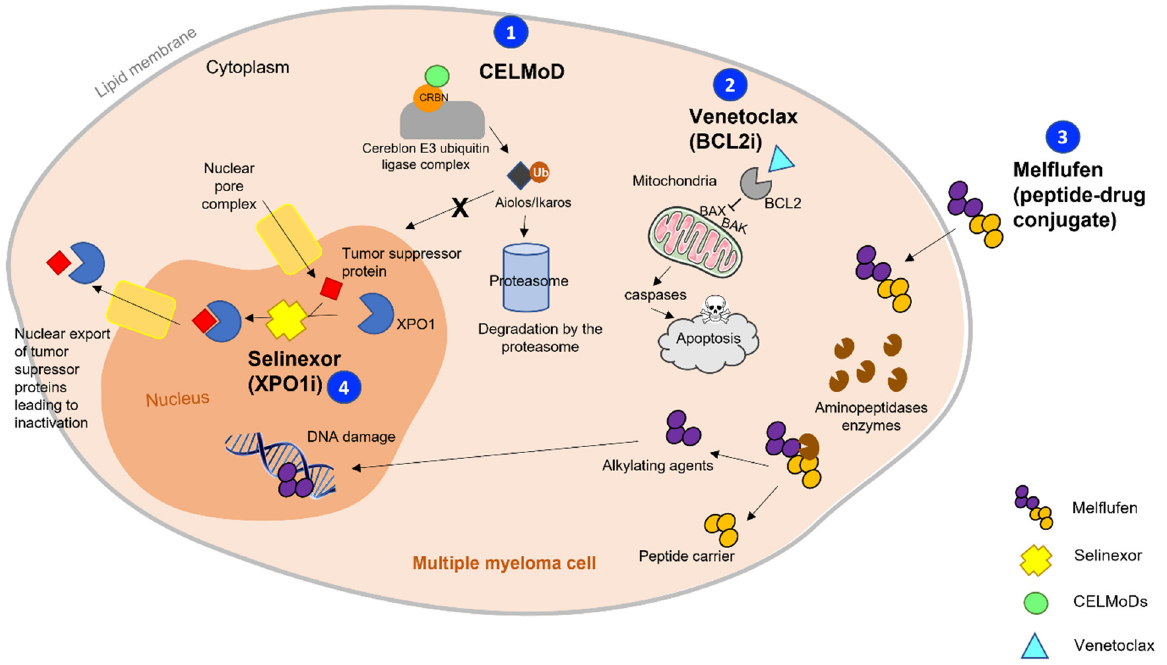
Figure 1. Overview of the mechanisms of action of the most innovative non-immunologic drugs currently in development for multiple myeloma: CELMoDs, BCL-2 inhibitors, peptide–drug conjugates, and XPO-1 inhibitors. (1) CELMoDs bind with high affinity to cereblon—part of the cereblon E3 ubiquitin ligase complex, which modulates the activity of the complex and increases the polyubiquitination of the transcription factors (TFs) Ikaros and Aiolos (zinc finger TFs of the Ikaros family), which are involved in MM cells’ survival and, therefore, their proteasome-dependent degradation. (2) Venetoclax binds to the BH3 domain of BCL-2 and, therefore, frees the pro-apoptotic proteins Bax and Bak that would be inhibited by BCL-2. Bax/Bak activation leads to their mitochondrial outer membrane permeabilization and initiates caspase-mediated apoptosis. (3) Melflufen is a peptide-conjugated alkylator that is rapidly internalized into cells due to its high lipophilicity. As a prodrug, it is metabolized by aminopeptidases, which are increased in MM cells, and selectively releases alkylating agent into tumor cells to exert its cytotoxic activity. (4) Selinexor targets XPO1, which is overexpressed in MM and performs the nuclear export of tumor-suppressor proteins (TSPs). Thus, blocking the action of XPO1 leads to the reactivation of TSPs, and then induces tumor cell apoptosis.